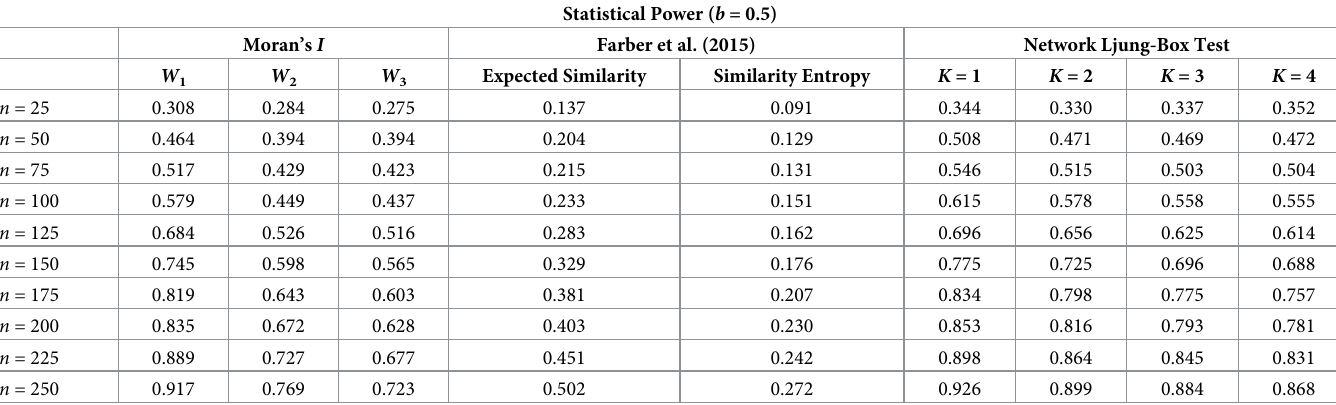
Table 2. Statistical power for positive network autocorrelation. Statistical power of tests for different values of n and K with b =